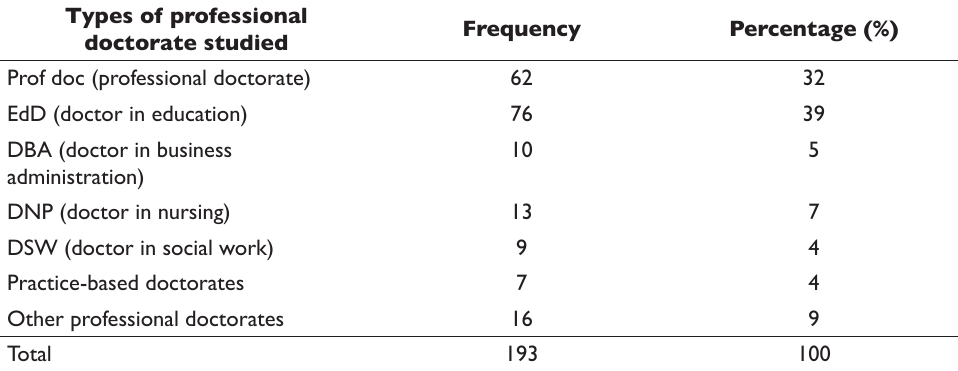
Table 1: Distribution of the literature by type of professional doctorate Types of